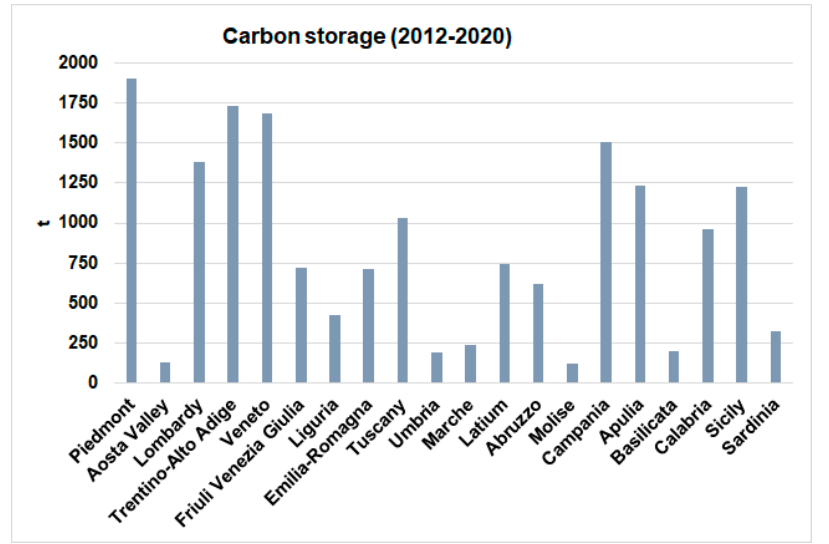
Figure 7. Tons of carbon storage lost due to land consumption in the period 2012–2020 at the regional level.